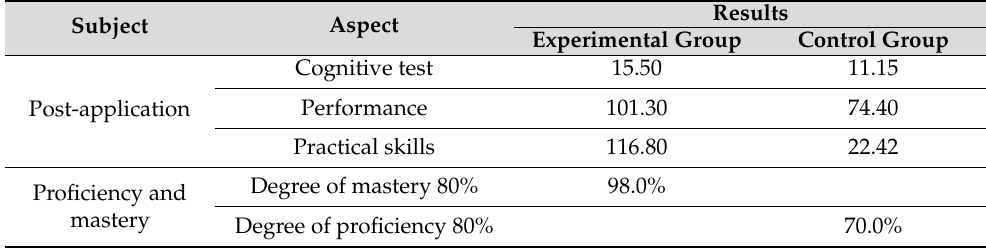
Table 11. Summarized achieved results of cognitive assessment of 3D virtual physics lab.